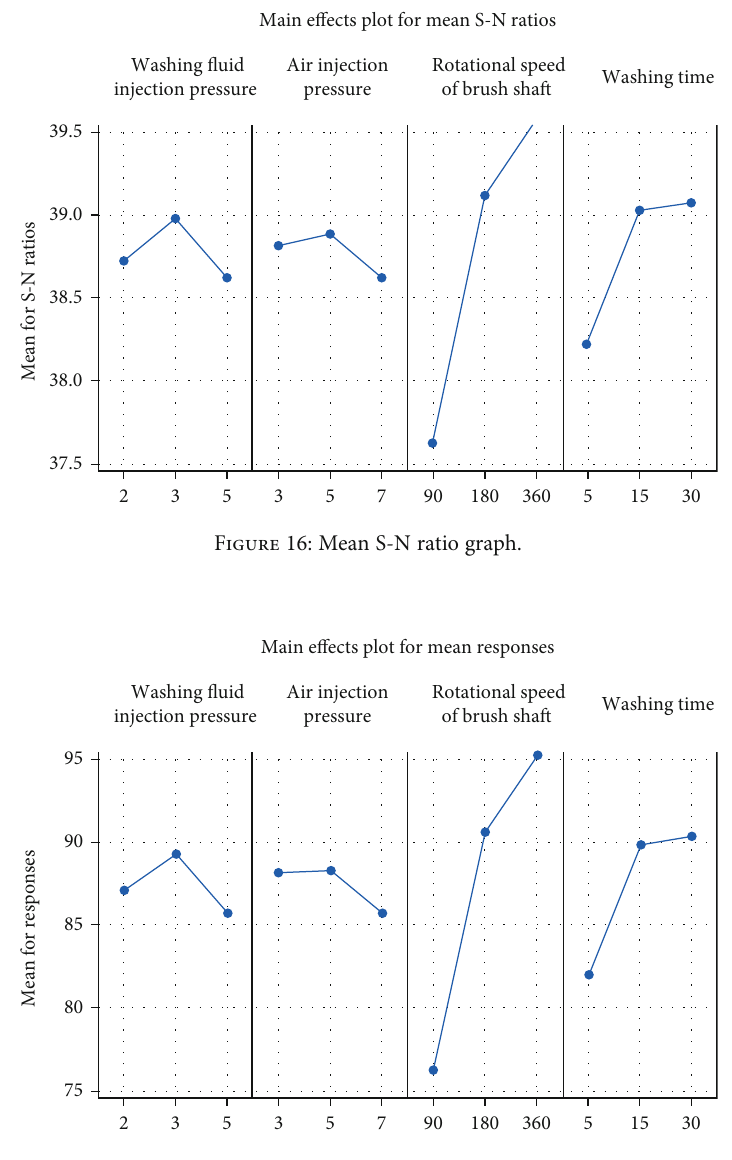
Figure 17: Mean response graph.